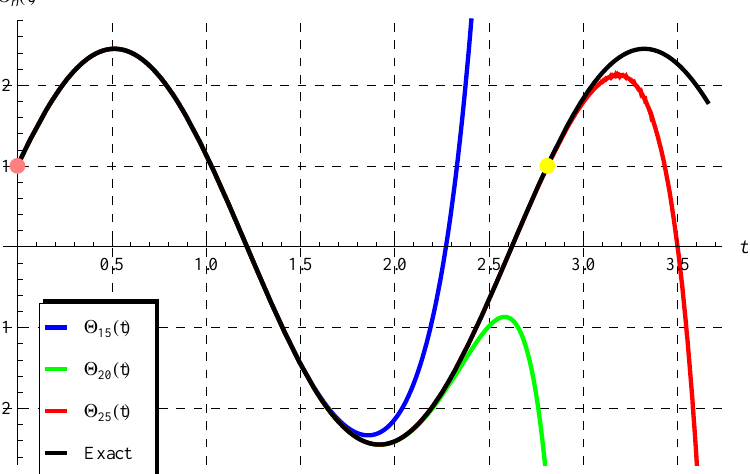
Figure 4. Comparisons between the approximate solutions Θ r ( t ) , r = 15,20, 25 in Equation (75) and the exact periodic solution (73) at λ = 1, a = 2, b = 3 ( c = −